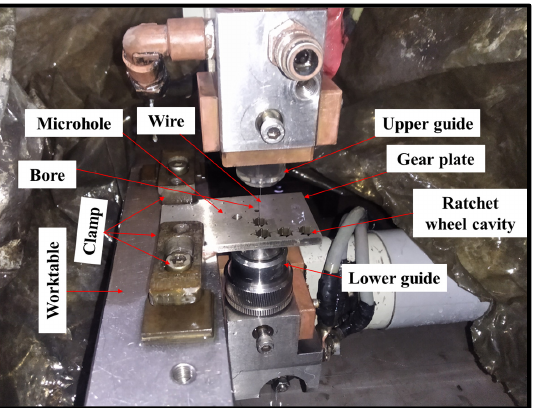
Figure 4. Closed view of machining chamber while manufacturing miniature-sized ratchet wheels by WEDM.